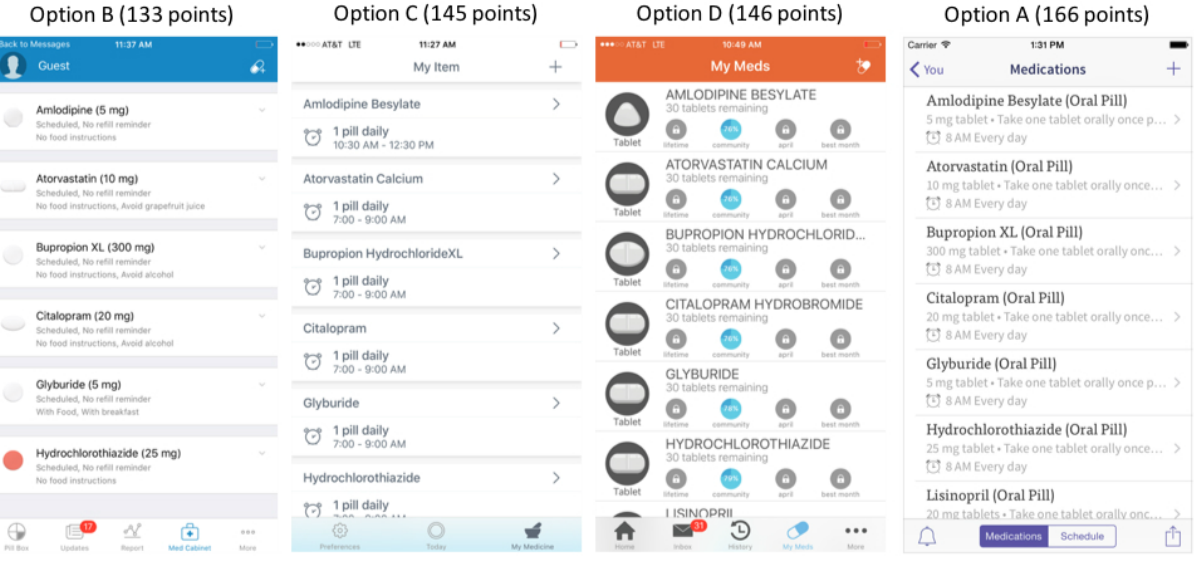
Figure 2. Medication list screenshots ranked from most preferred (lower score) to least preferred (higher score) based on design and visual appeal and respective scaled